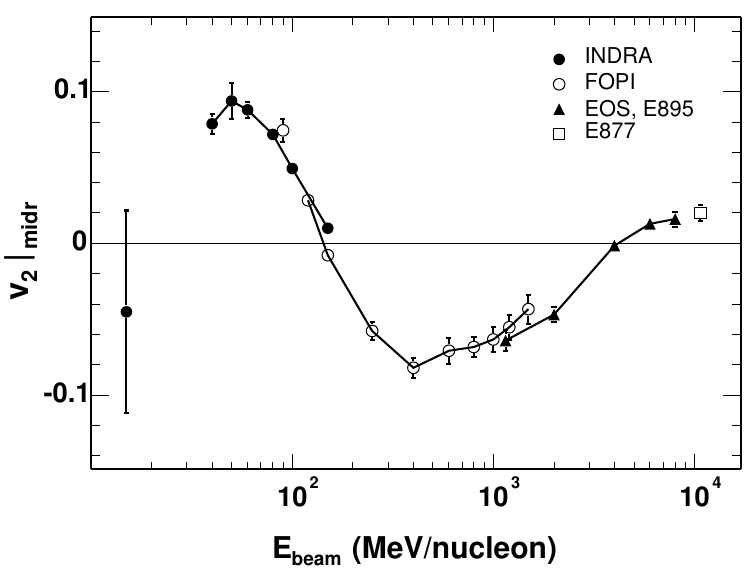
Figure 4. Elliptic flow parameter v 2 at midrapidity for 197 Au+ 197 Au collisions at intermediate impact parameters ( 5.5–7.5 fm) as a function of incident energy. The filled and open circles represent ≈ the INDRA and FOPI data for Z = 1 particles, the triangles represent the equation-of-state (EoS) and E895 data for protons, and the squares represent the E877 data for all charged particles. Figure taken from [33] with permission, where the references to the data are also